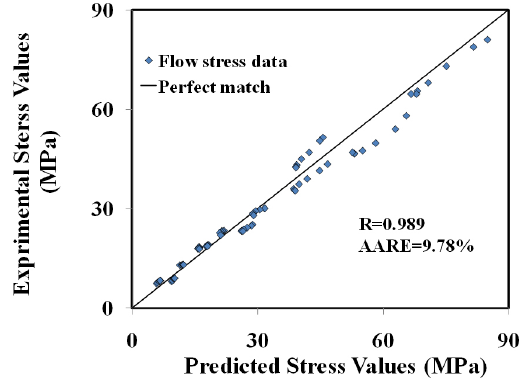
Figure 7. The correlation between the experimental and predicted flow stress data from the proposed constitutive equation over the entire range of strain, strain rate and